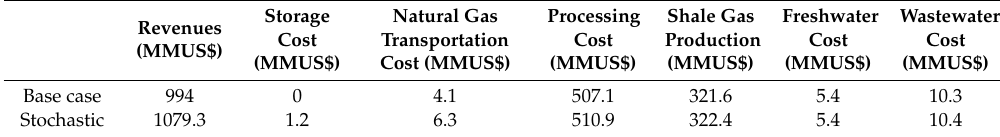
Table 3. Income and costs obtained in deterministic (base case) and stochastic cases.